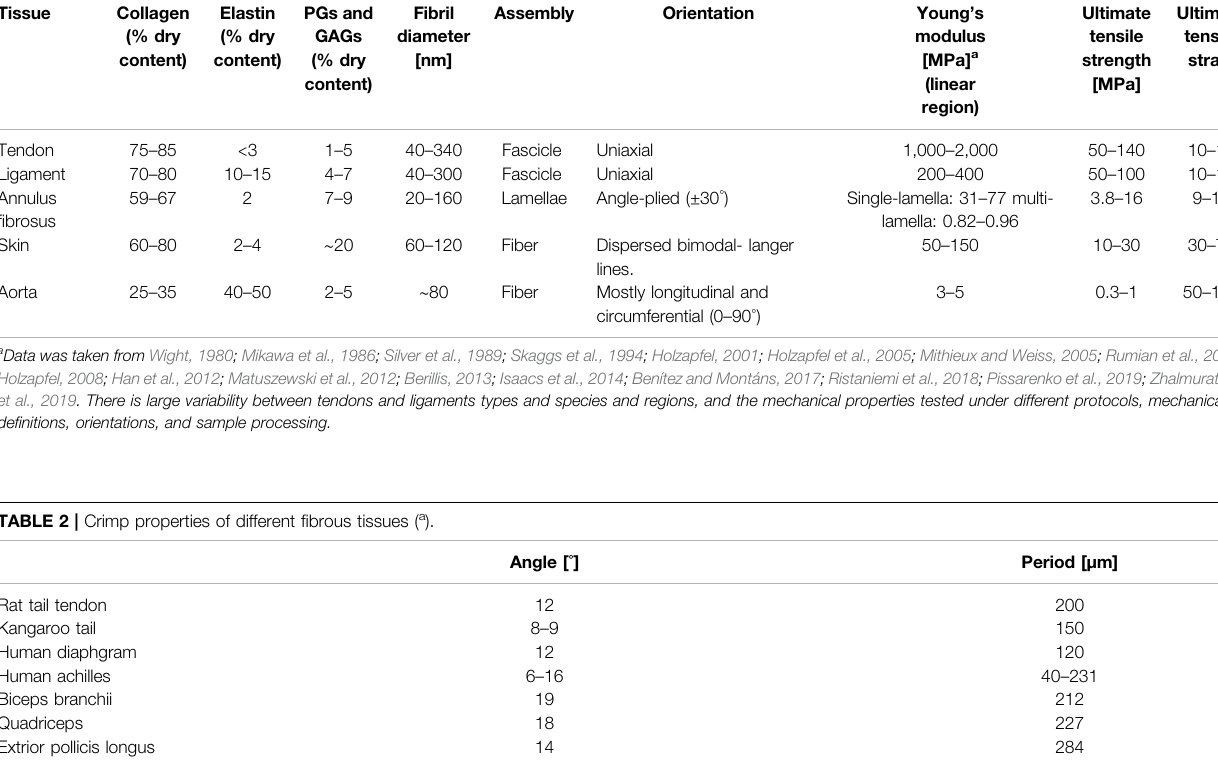
TABLE 1 | Representative structural and mechanical properties of different soft fi brous tissues a . Tissue Collagen (% dry